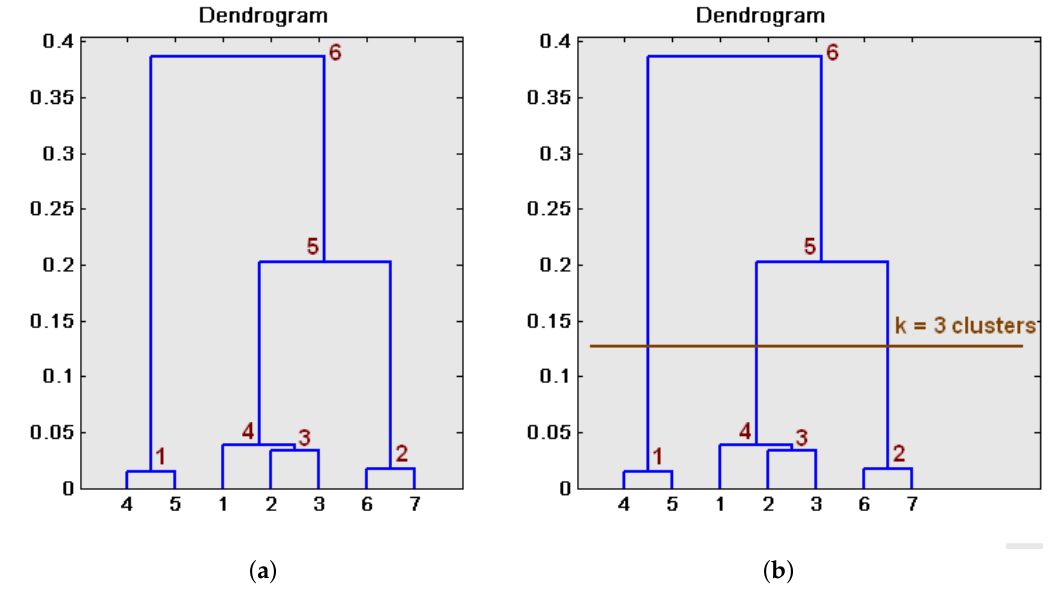
] T , (cid:126) g Pos ,. . ., (cid:126) g Pos 2 7 1